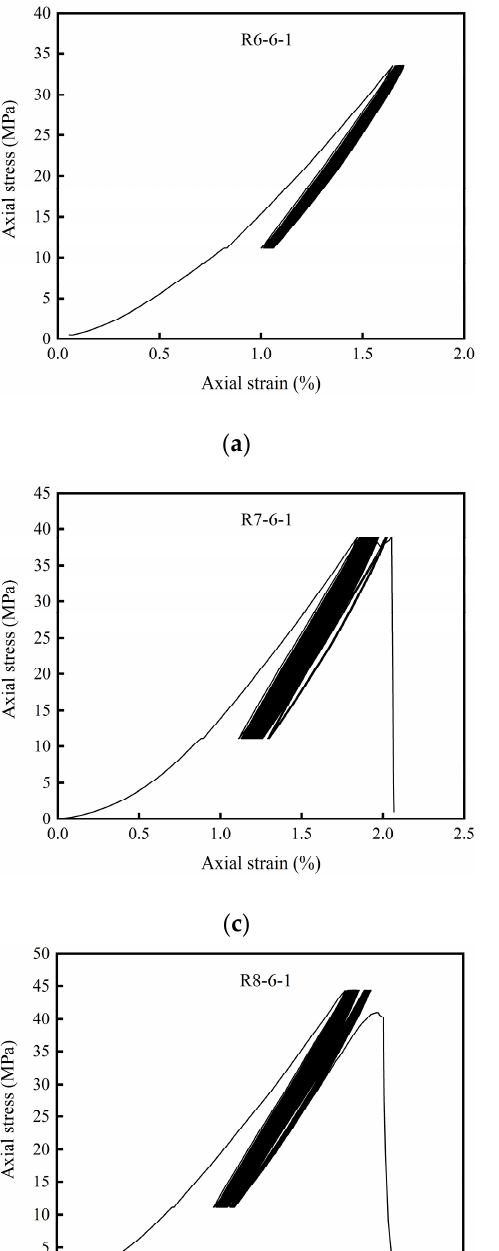
( c ) Figure 11. The relationship between the cyclic loading and unloading peak strain and cycle number when the stress upper limit is ( a ) 60%, ( b ) 70%, and ( c ) 80% of